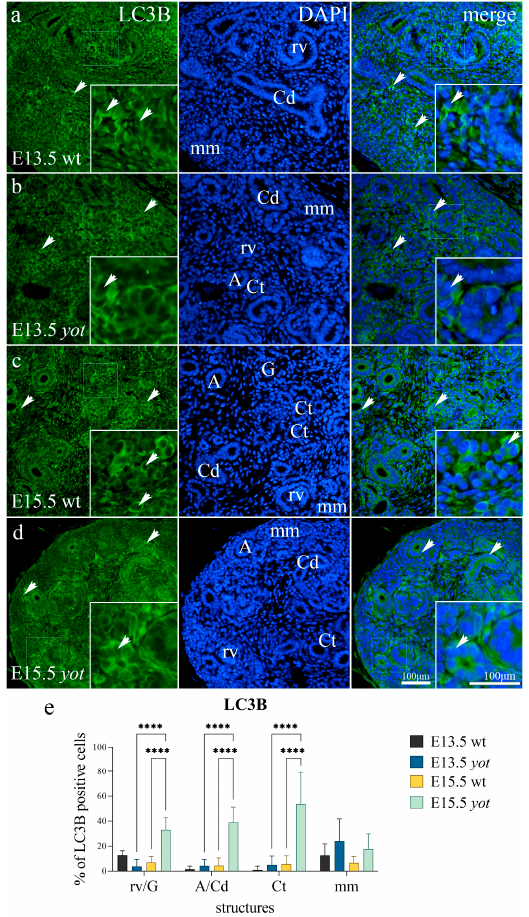
Figure 1. Immunofluorescence staining of developing wild-type (wt) ( a , c ) and yotari ( b , d ) mouse kidneys with LC3B marker and DAPI nuclear staining. Three mice were used for each genotype ( yotari and wt) at every observed time point. Arrows show the expression pattern of LC3B in the metanephric mesenchyme (mm), renal vesicles (rv), glomeruli (G), convoluted tubules (Ct), ampul- lae (A), and collecting ducts (Cd) indicated on the 4 ′ ,6-diamidino-2-phenylindole (DAPI) image. The most prominent protein expression area is shown in the inserts, corresponding to the dashed boxes. Images were taken at a magnification of ×40. The scale bar is 100 µm, which refers to all images. Graph ( e ) shows the distribution of the percentage of LC3B-positive cells in the metanephric mes- enchyme (mm), renal vesicles (rv) or glomeruli (G), convoluted tubules (Ct), and ampulla (A) or collecting ducts (Cd) of wild-type and yotari kidneys at embryonic days E13.5 and E15.5. Data are presented as the mean ± SD (vertical line) and analyzed by a two-way ANOVA test followed by Tukey’s multiple comparison test. Significant differences are indicated by **** p < 0.00001. At each time point, ten substructures were assessed.